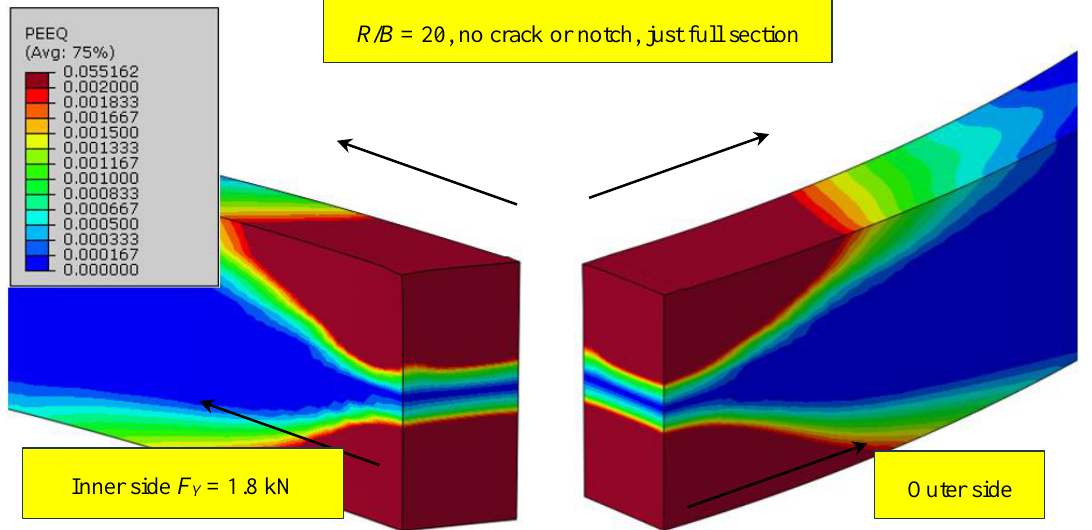
R / B = 20, no crack or notch, just full section